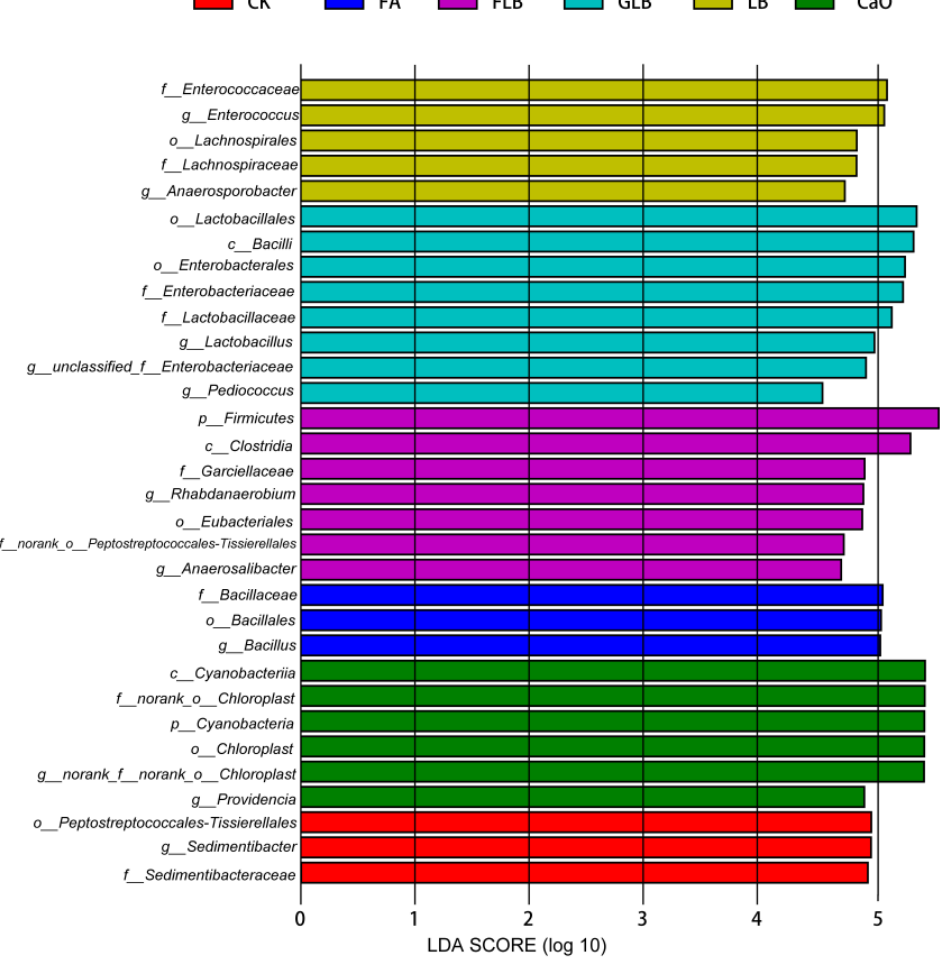
Figure 5. The differentially abundant bacterial taxa identified by linear discriminant analysis effect size (LEfSe) among treatments (CK, FA, CaO, LB, GLB, and FLB) and their cladograms. LDA, linear discriminant analysis. CK, control, no additive; FA, 0.6% formic acid; CaO, 3% calcium oxide and 3% urea; LB, 1 × 10 6 cfu/g L. buchneri ; GLB, 2% glucose and 1 × 10 6 cfu/g L. buchneri ; FLB, 2% fucoidan and 1 × 10 6 cfu/g L. buchneri